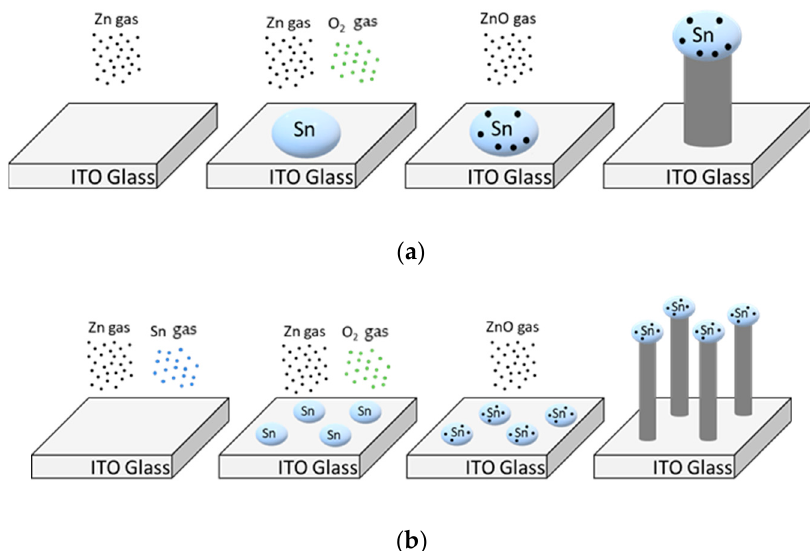
Figure 3. Schematics of the vapor–liquid–solid process using ( a ) only Zn powder and ( b ) Zn and Sn powder on ITO.